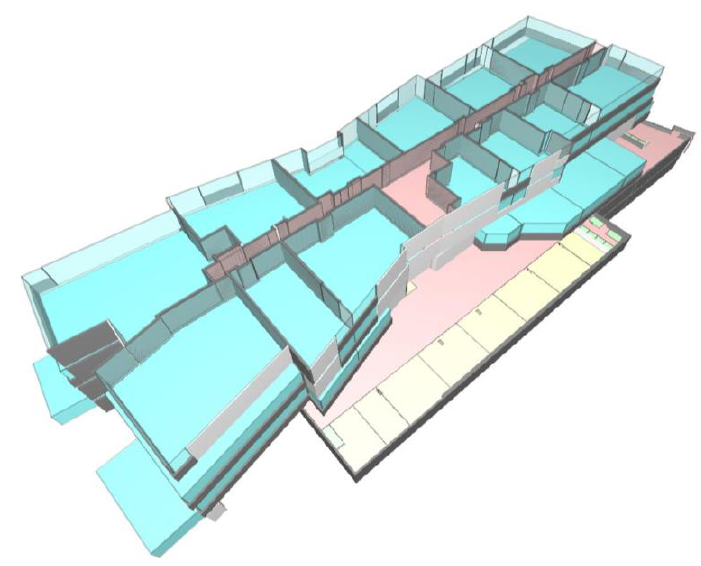
Figure 8. Legal spaces and their wall boundaries. Figure 7. Legal spaces and their wall boundaries.